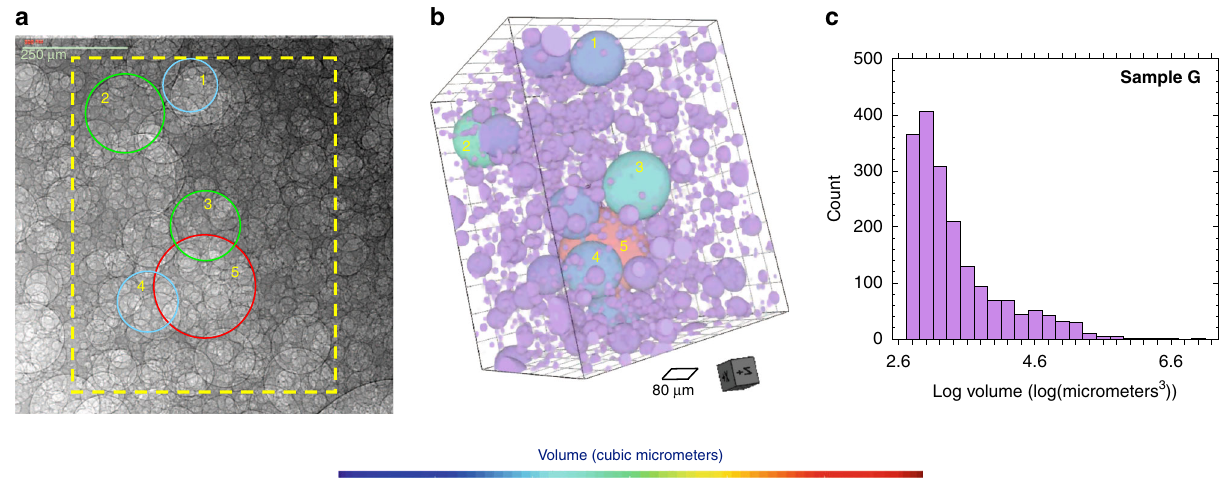
Fig. 1 Bubble geometry in a dust grain. a 2D projection (dashed yellow outlines reconstructed region in b ). b 3D reconstruction of a subregion (622.34 × 797.43 µ m × 600.57 µ m 3 ) of a single grain taken with a 20× objective on a 3D X-ray microscope showing bubbles with radii greater than fi ve pixels. The color scale in b represents bubble volume. The red bubble in b is the bubble circled in red in a . The diameter of the red circle in a is 243 µ m. The pixel resolution is given in Supplementary Table 1. c Probability distribution of the log of bubble volume for bubbles shown in b .